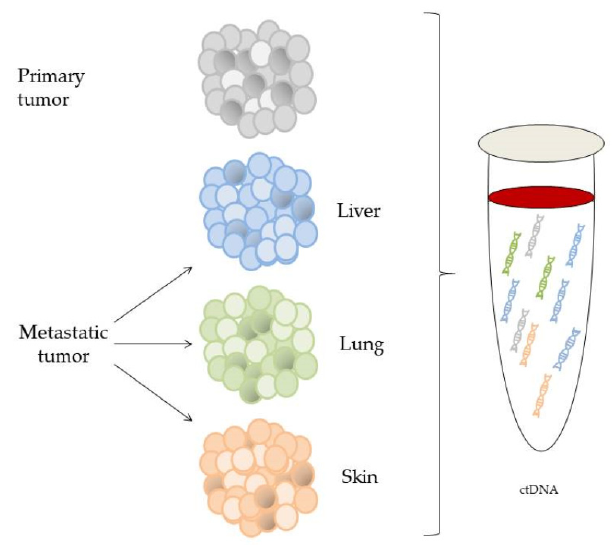
Figure 2. Circulating tumor DNA (ctDNA) reflects the genomic profile of different tumor localizations in metastatic melanoma and better recapitulates the heterogeneity of the disease. cfDNA can be isolated from different body fluids. When cfDNA is obtained from the peripheral blood, plasma is preferred to serum, especially because the large amounts of wild-type DNA released by white cell lysis during clotting can cause a further dilution of ctDNA. To prevent clotting and DNase I activity, it is recommended to use ethylenediamine-tetraacetic acid (EDTA) tubes or tubes containing formaldehyde-free preservative reagents for blood collection [9]. When EDTA- containing tubes are used to collect blood, plasma separation must be performed within 4 h of drawing to prevent the lysis of leukocytes [10,11].